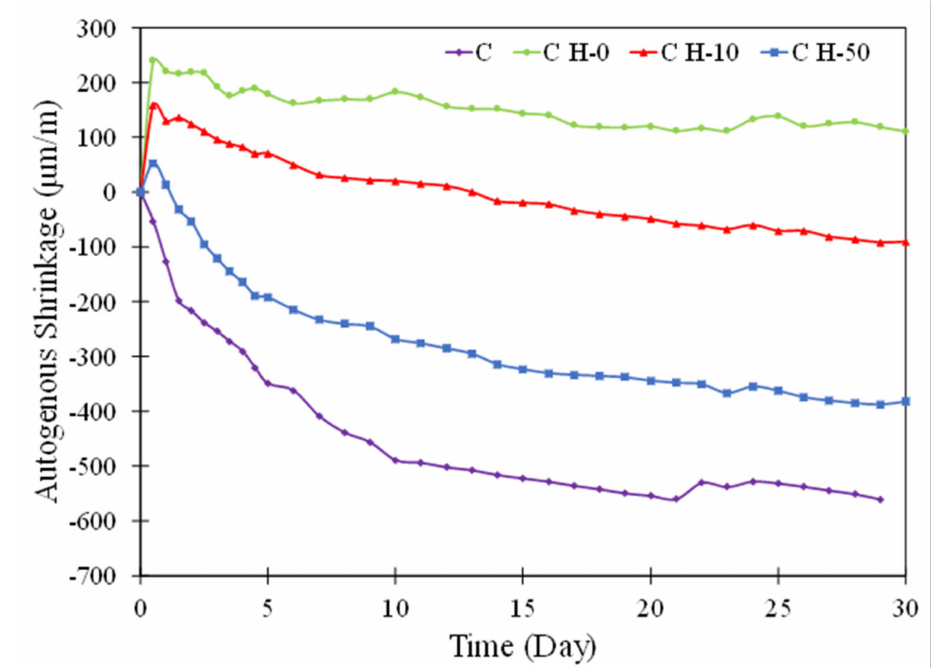
Figure 6. Autogenous shrinkage of the control cement paste and the pastes containing hydrogels at different ages.